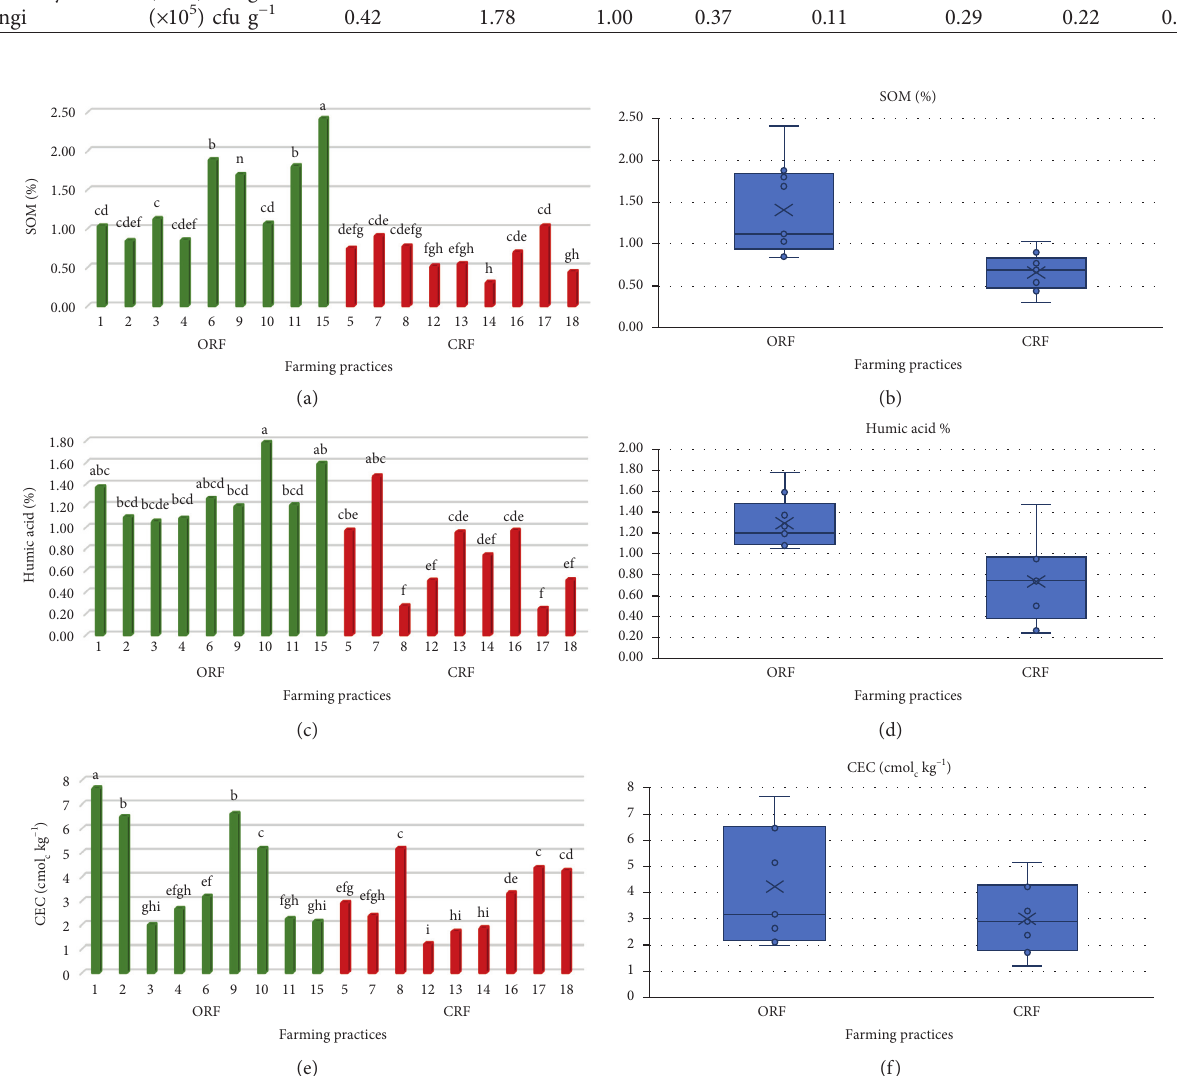
Figure 4: Soil organic matter (SOM) (a, b), humic acid (c, d), and cation-exchange capacity (CEC) (e, f) of the soils in organic and conventional farming (ORF and CRF, respectively). The error bars represent the standard deviation of measurements for nine soil